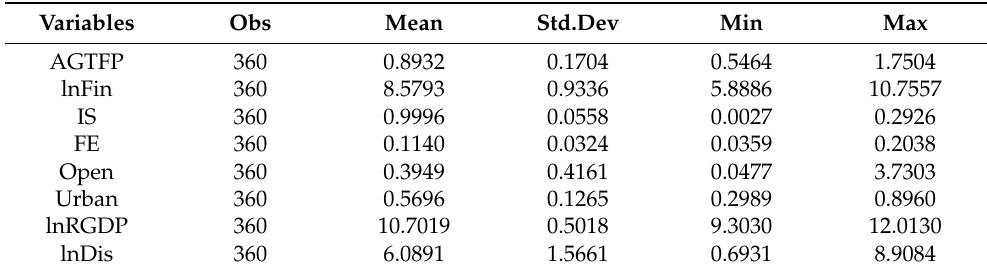
Table 4. Statistical description of the sample.